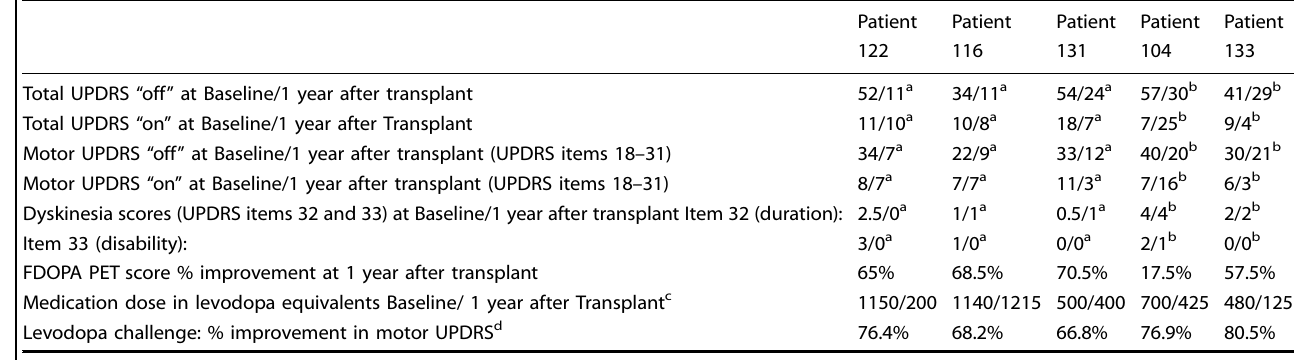
Table 1. Quantitative results of the subjects with persistent